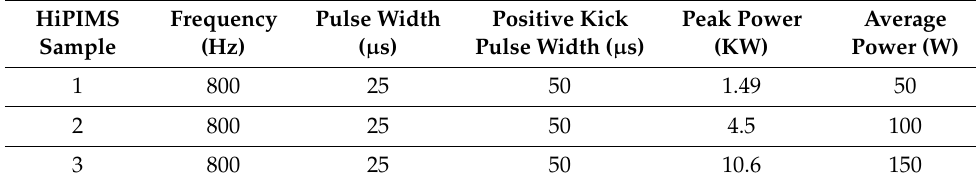
Table 1. HiPIMS deposition